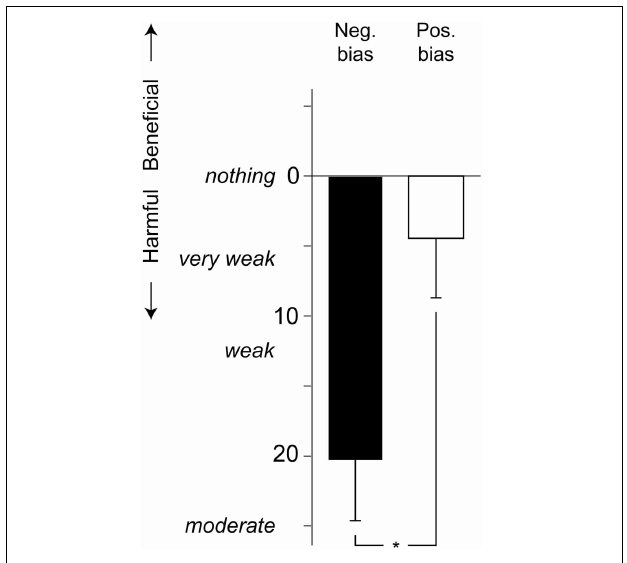
FIGURE 2 | Mean ( + standard error) ratings of harmful or beneficial health effects of the chemical exposure, using a Borg CR-100 scale. P- values refer to the ANOVA parameter estimates ( ∗ p < 0 . 05).